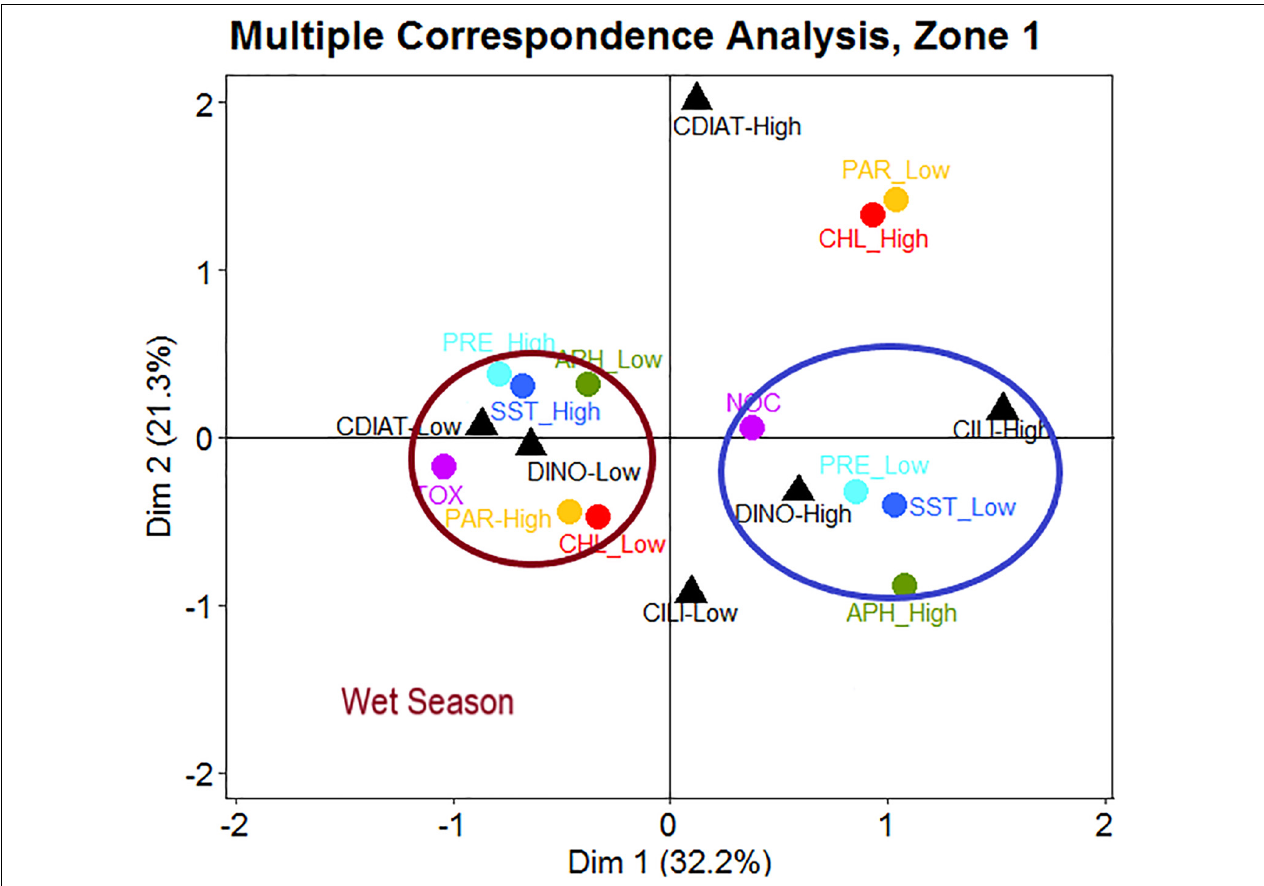
FIGURE 7 | In Zone 1, occurrences of toxic HABs (TOX) linked to low concentrations of dinoflagellates (DINO) and centric diatoms (CDIAT) are associated with high levels of sea surface temperature (SST), precipitation (PRE), and photosynthetic active radiation (PAR) as well as low levels of absorption coefficient of phytoplankton at 443 nm (aph) and chlorophyll a (chl-a) appearing during the wet season. Events of non-toxic HABs (NOC) appearing with high concentrations of DINO and ciliates (CILI) are associated with low levels of SST and PRE, accompanied by high values of